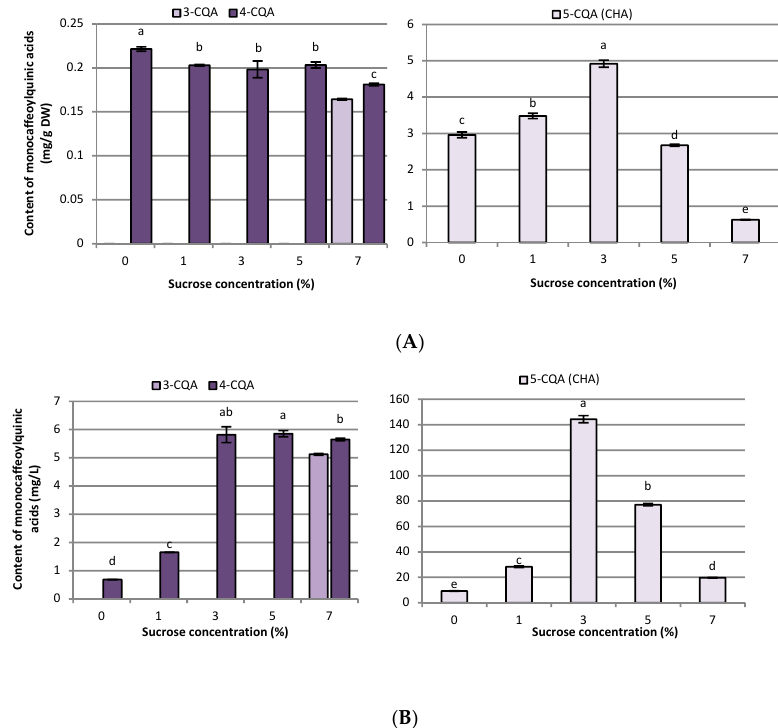
Figure 3. Effect of sucrose concentration (0–7%) on monocaffeoylquinic acid derivative contents in ( A ) mg g − 1 DW and ( B ) mg L − 1 in R. carthamoides transformed roots cultured in 50 mL of liquid WPM medium in a 300 mL Erlenmeyer flask, in light conditions (16/8-h light/dark photoperiod) on a rotary shaker at 80 rpm. The results are means values ± SE ( n = 9). Different letters for the same metabolite signify significant differences between the sucrose concentrations ( p < 0.05). 3-CQA-3- O -caffeoylquinic acid; 4-CQA-4- O -caffeoylquinic acid; 5-CQA-5- O -caffeoylquinic acid (CHA, chlorogenic acid).